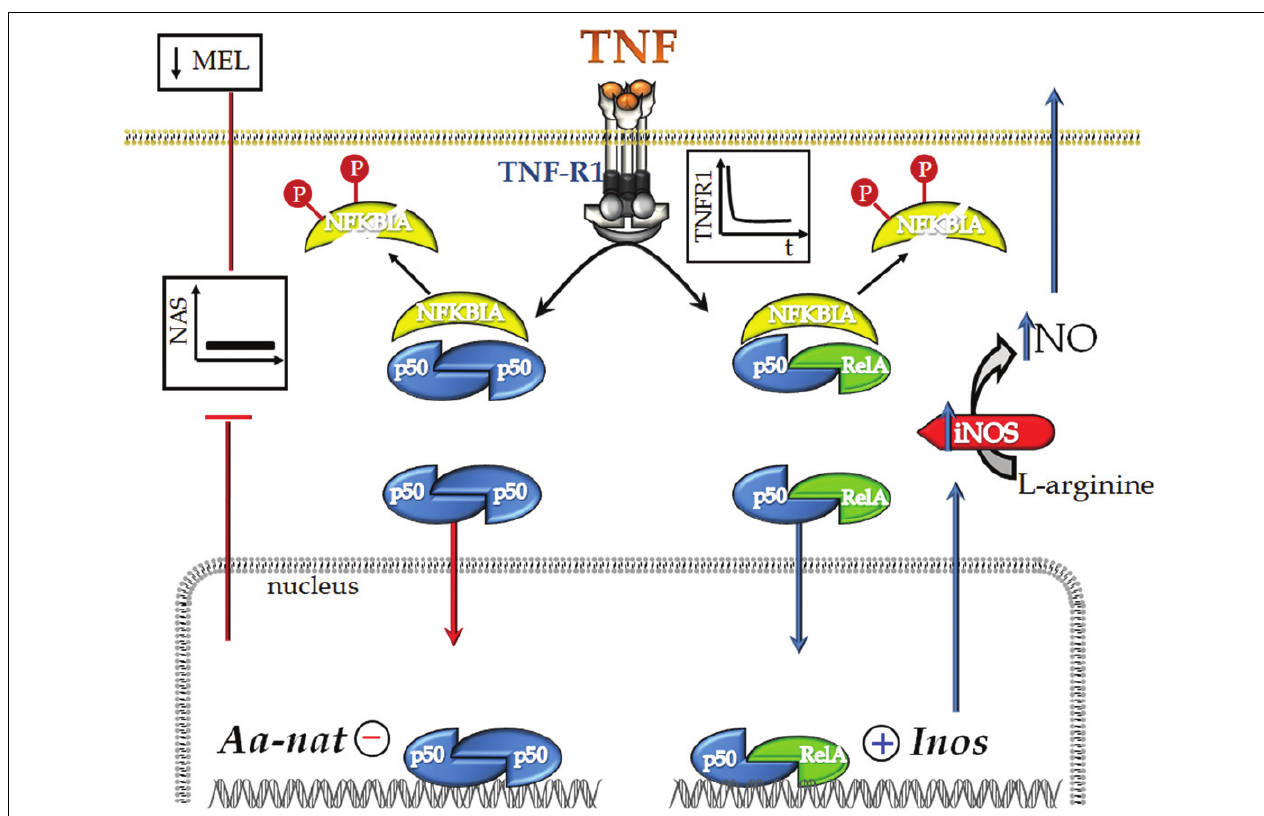
which encodes the key protein for melatonin synthesis (Fernandes et al., 2006). In fact,TNF inhibits melatonin synthesis. Here, we also show that the nuclear translocation of p50/RelA induces the transcription of iNOS, a hallmark enzyme of inflammatory responses.We suggest that the mechanism of action ofTNF, as determined in the present paper, is the molecular basis for understanding the inhibition of melatonin synthesis that occurs at the beginning of an innate immune